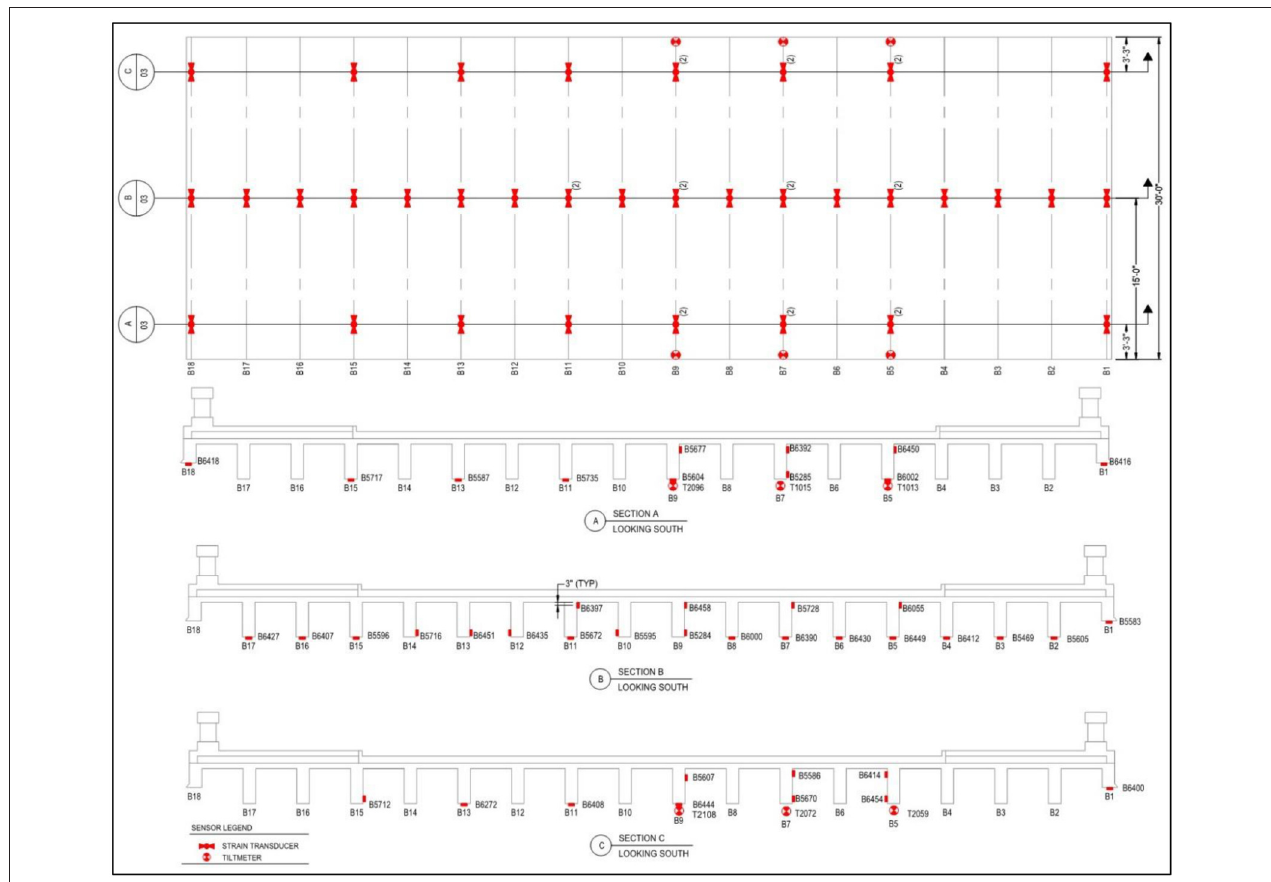
FIGURE 3 | Instrumentation plan for a multi-beam RC T-Beam